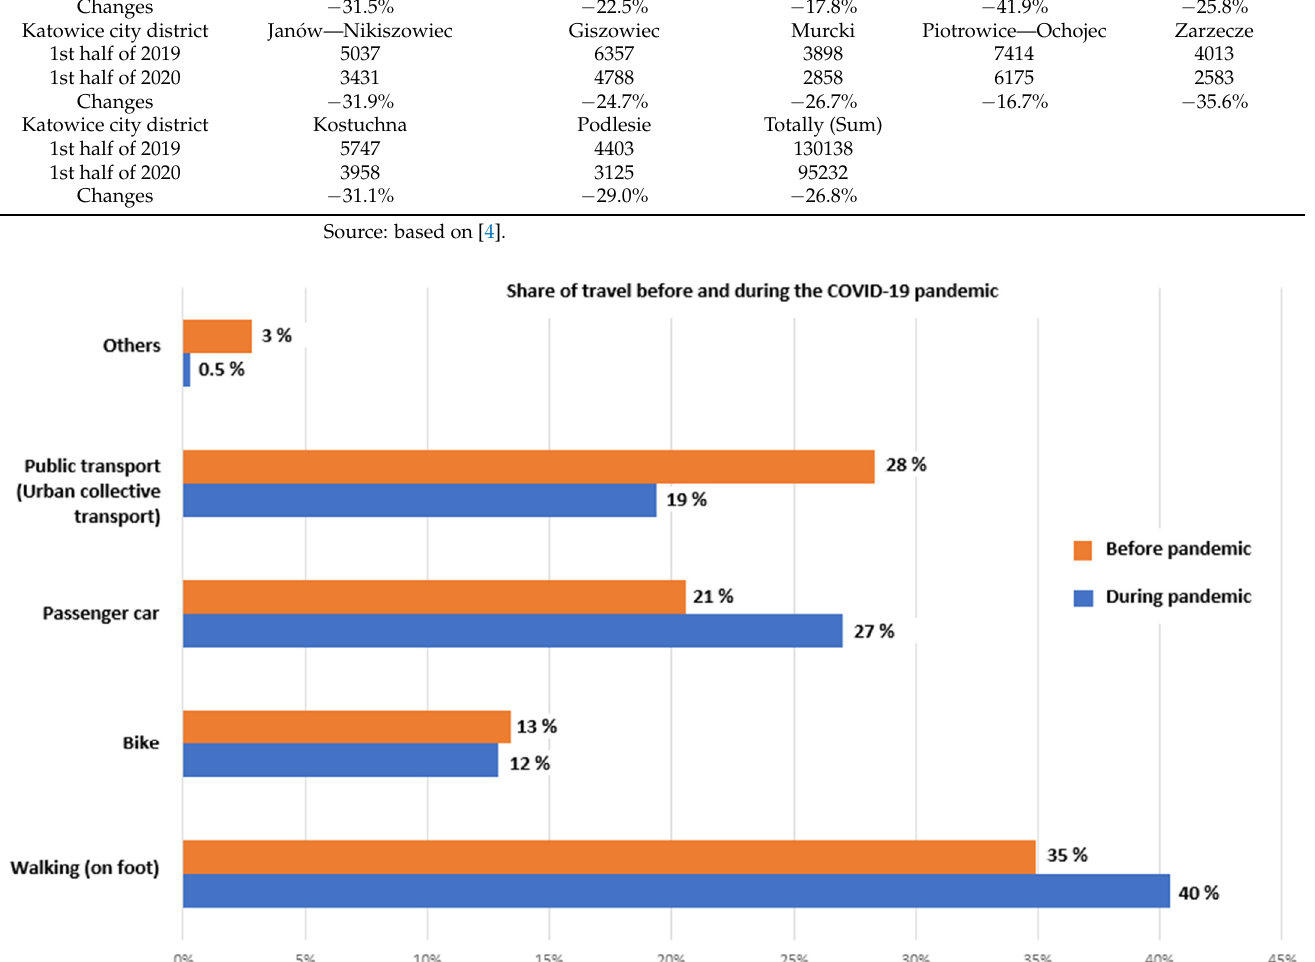
Figure 8. Changes in transport needs during the pandemic. Source: based on [4]. In the following months of the pandemic, the size of the decreases was smaller. Start- ing from May 2021, the volume of traffic returned and even exceeded reference volumes. This was due to the return of the economy to pre-pandemic activity as well as increased mobility and a large degree of disregard for lockdown restrictions. It can be assumed that